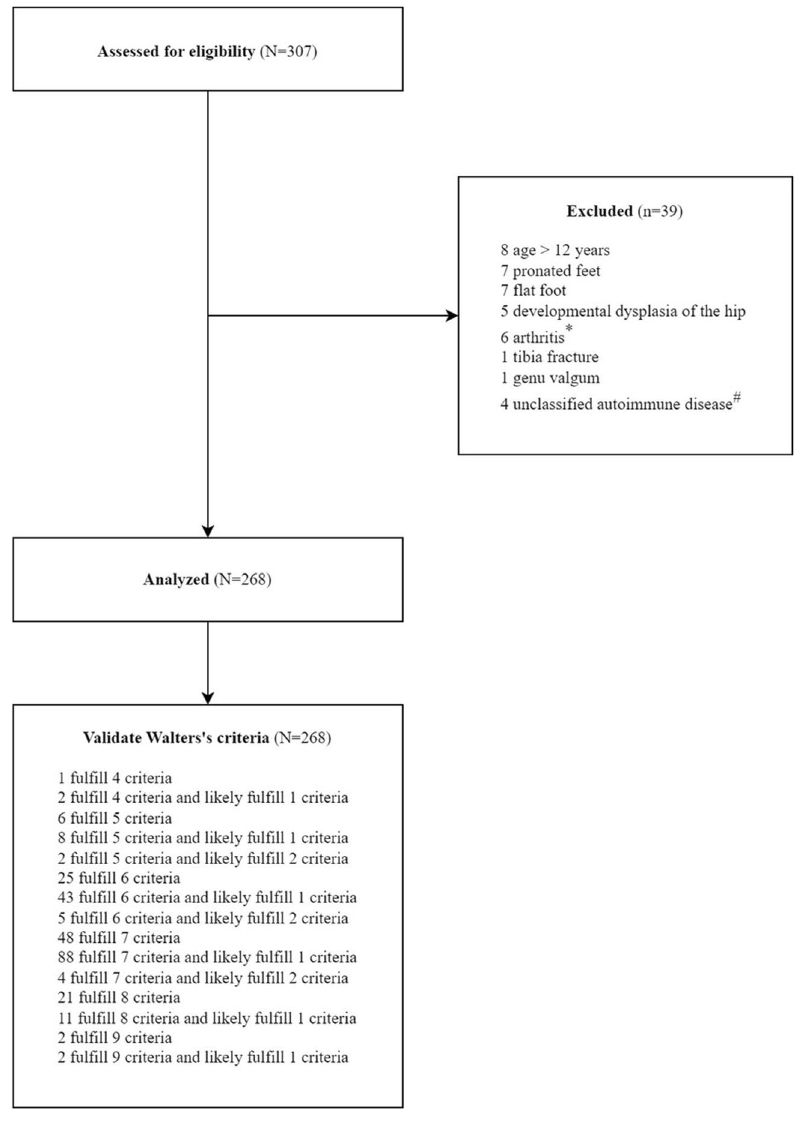
Figure 1. Study flow